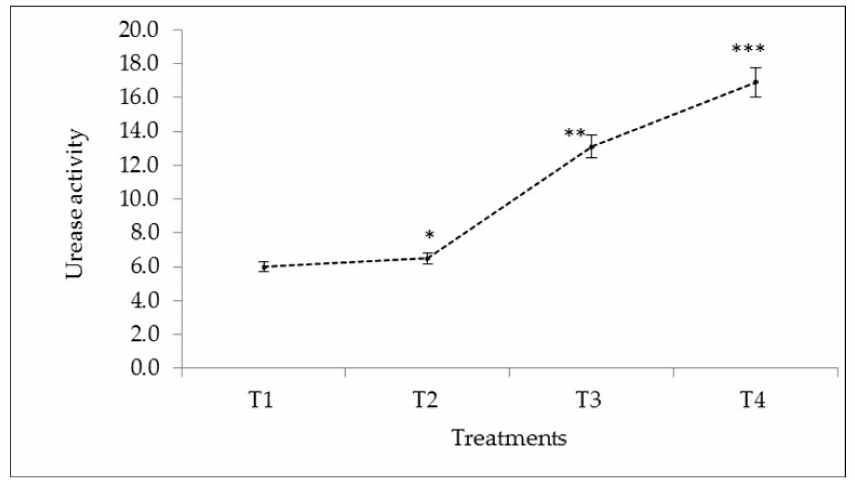
Figure 1. The effect of mineral fertilisers on urease activity of irrigated soil in Kibray district, Tashkent Region, Uzbekistan. ( p values showing significantly different at p < 0.05 *, p < 0.01 **, p < 0.001 *** as compared to control (T1)). Bars represent ± SD values.